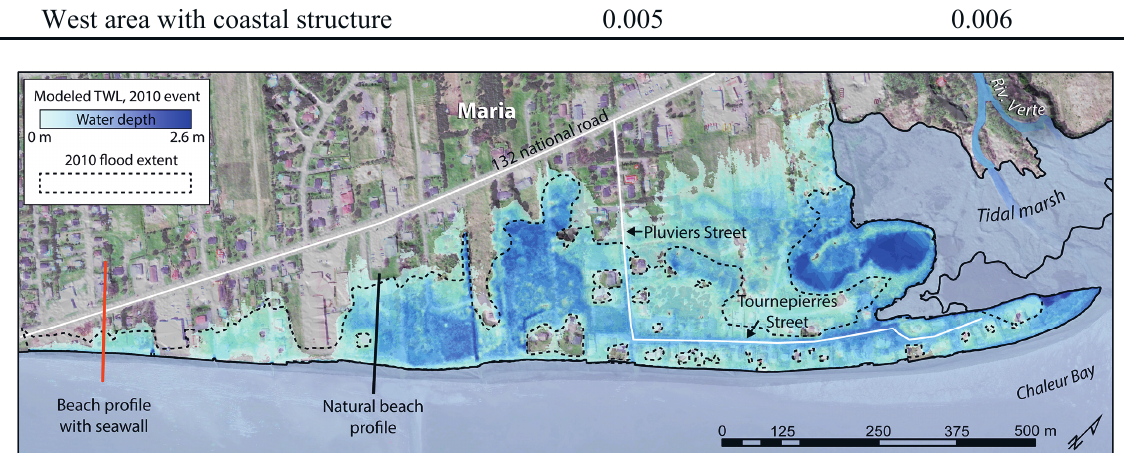
Figure 10. Modelled total water levels for the 2010 flood extent. The dashed line represents the observed flood extent during the post-storm survey. Red and black lines show profiles illustrated in Figure